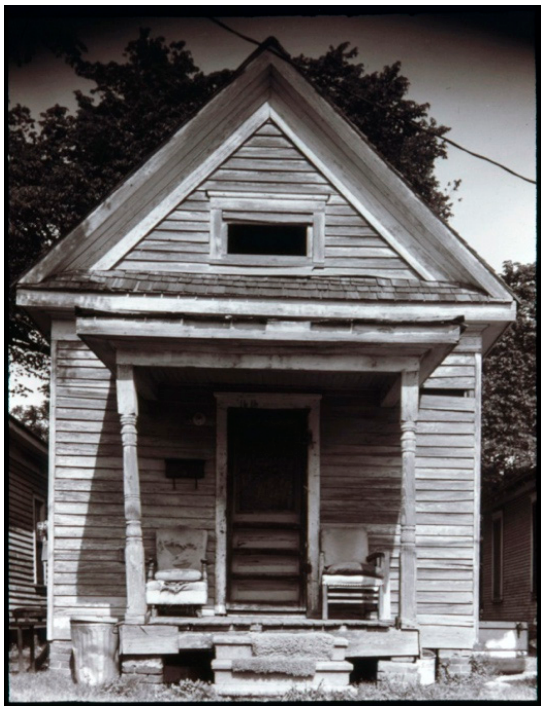
Figure 7. Shotgun in Fifth Ward, Houston from the 1970s. Photograph by Danny Lyon.